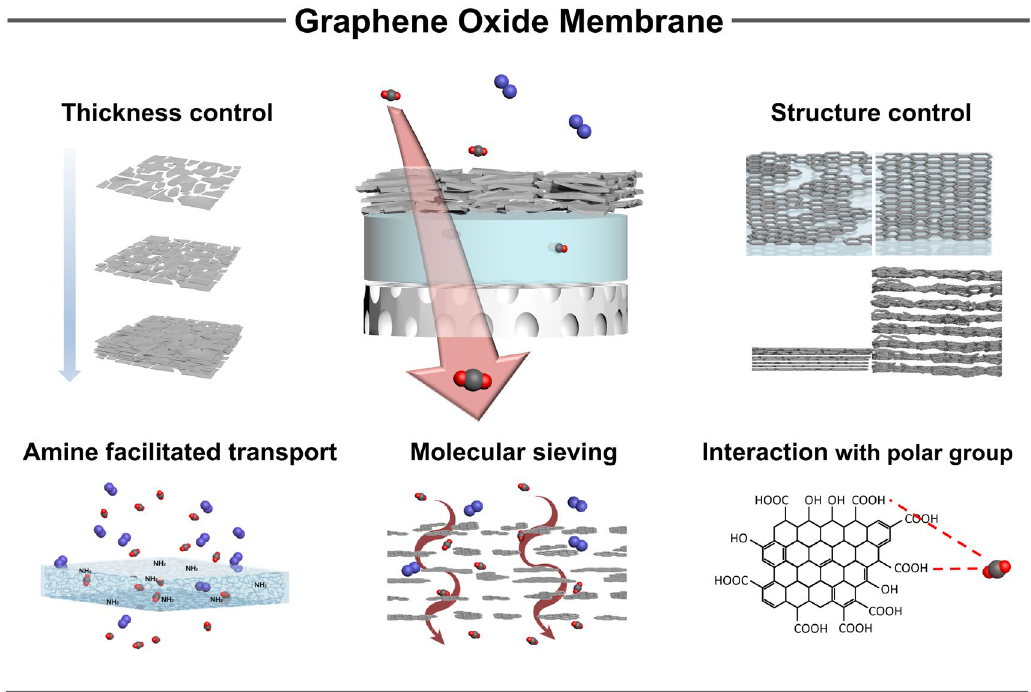
Figure 1. Schematic illustration of LbL-assembled polyelectrolyte/GO membranes for CO 2